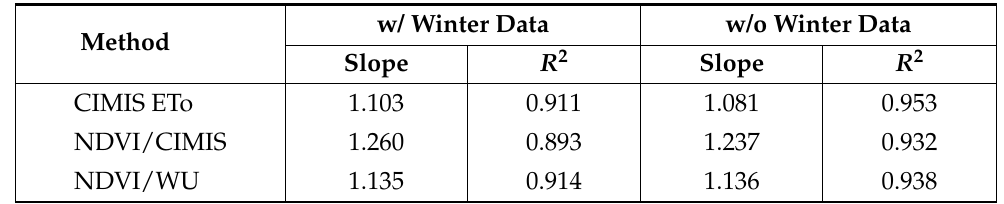
Table 5. Model parameters for the best fit through the origin (0, 0) to correlate sap flow-based ET with the ET o and NDVI/weather-based ET.